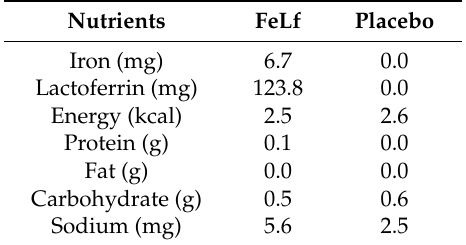
Table 3. Compositions of the iron-lactoferrin complex (FeLf) and placebo tablets 1 . Nutrients